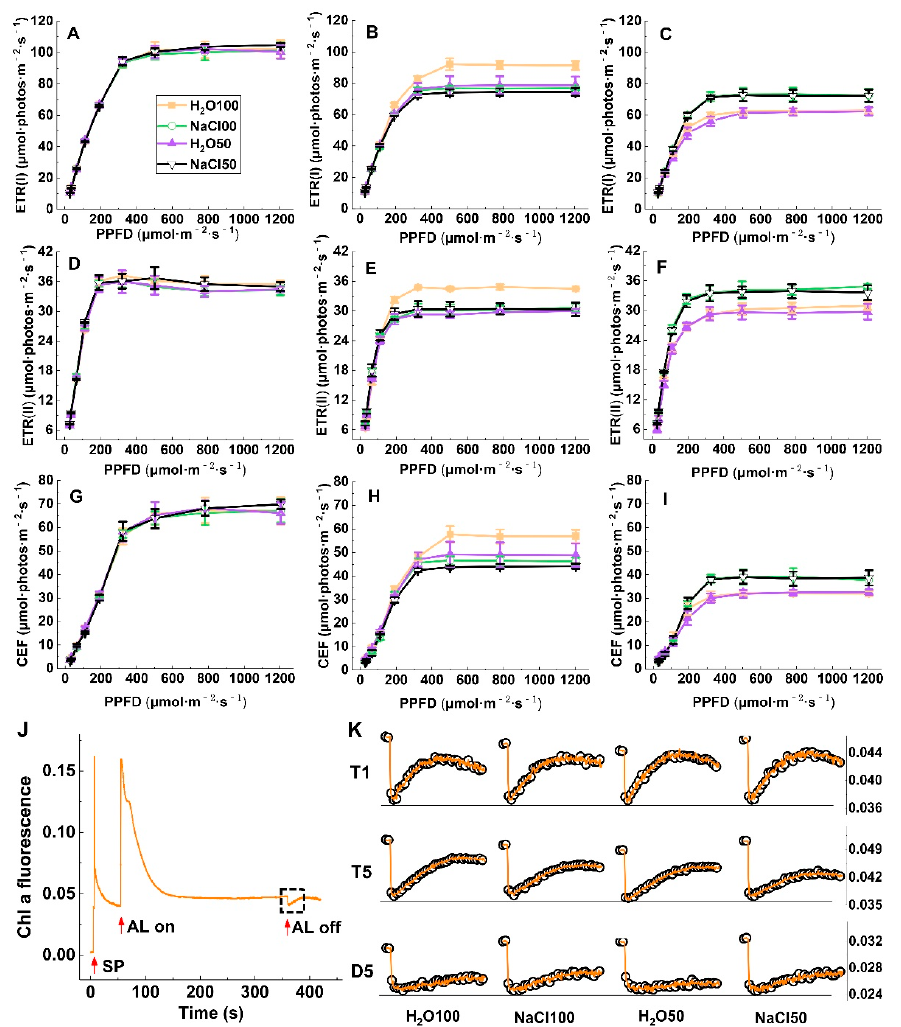
Figure 4. The effect of soil salinity on linear and cyclic photosynthetic electron transport of tomato leaves under subsequent drought stress. A-C, ETR(I) at T1 ( A ); T5 ( B ); and D5 ( C ). D-G, ETR (II) at T1 ( D ); T5 ( E ); and D5 ( F ). G-I, CEF at T1 ( G ); T5 ( H ); D5 ( I ); A standard measurement procedure